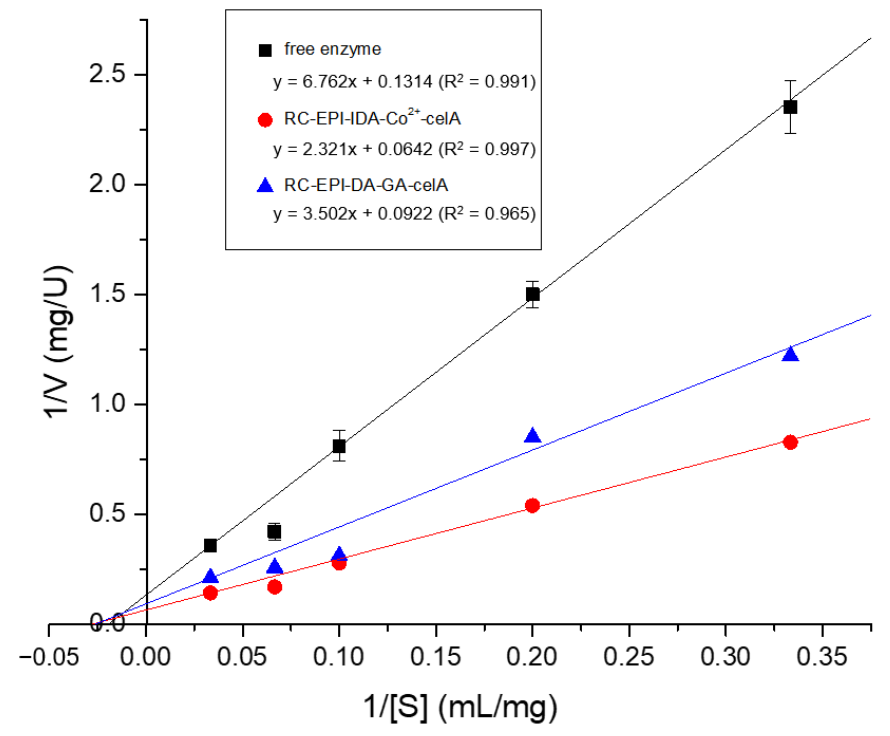
Table 2. Kinetic parameters of free and immobilized CelA endoglucanase.